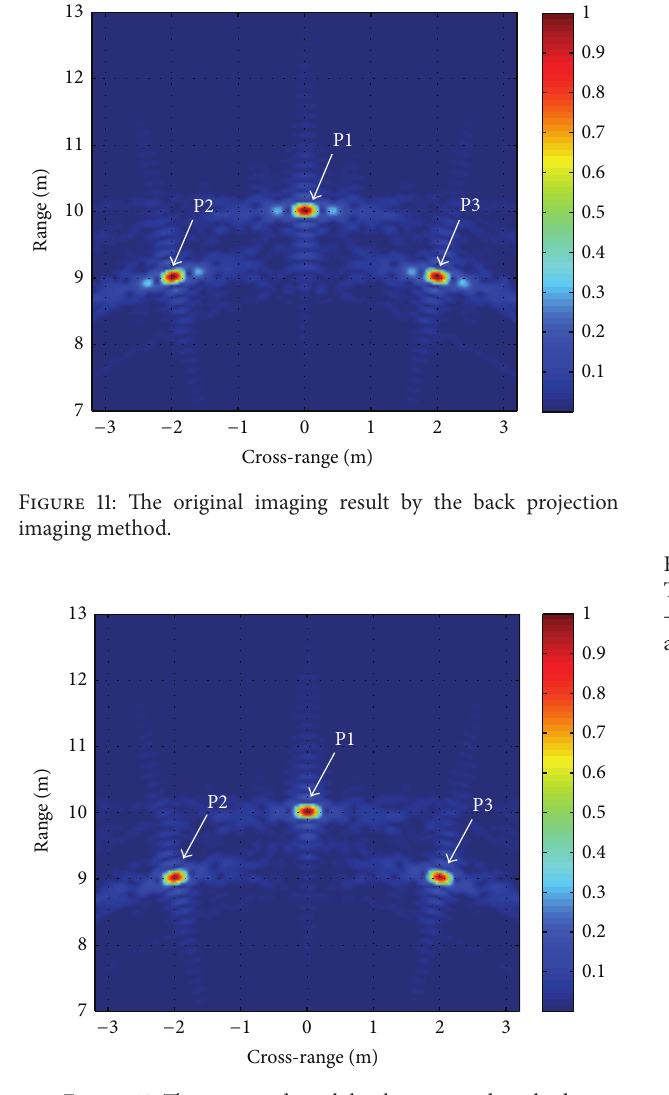
Figure 12: The processed result by the proposed method.